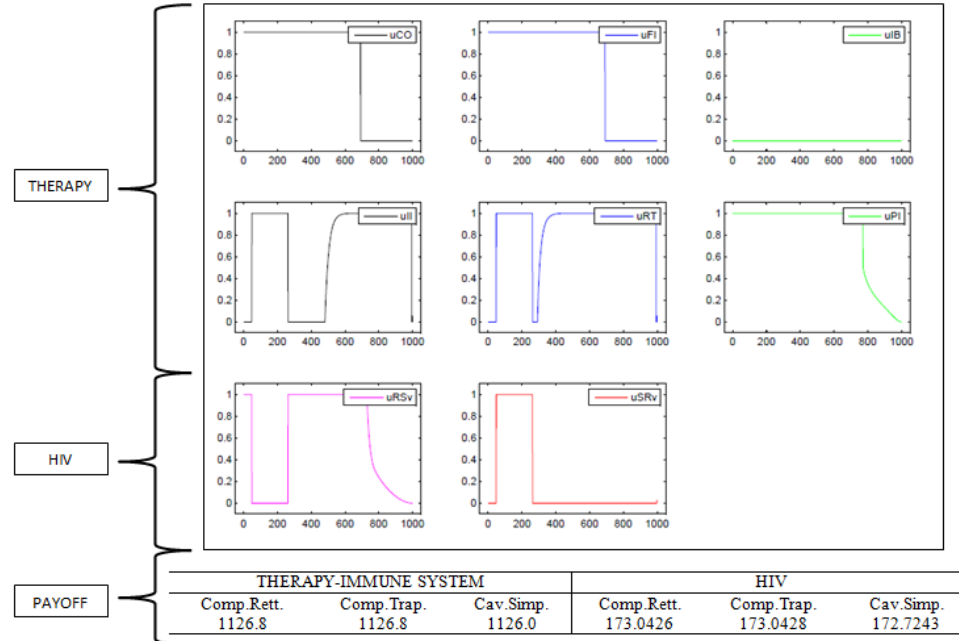
Figure 5. Equilibrium strategies and payoffs (nonconcave instance).